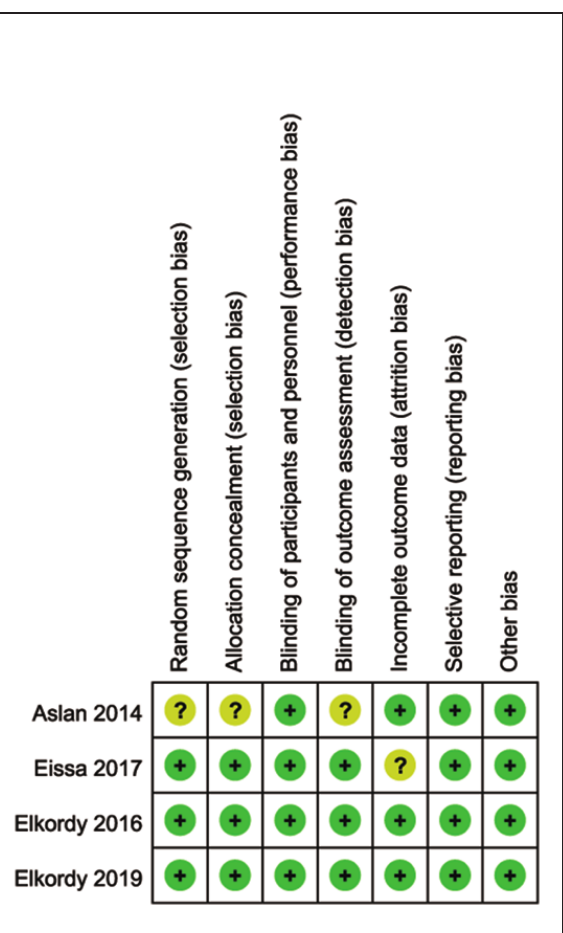
Figure 2. Risk of bias summary for RCTs.